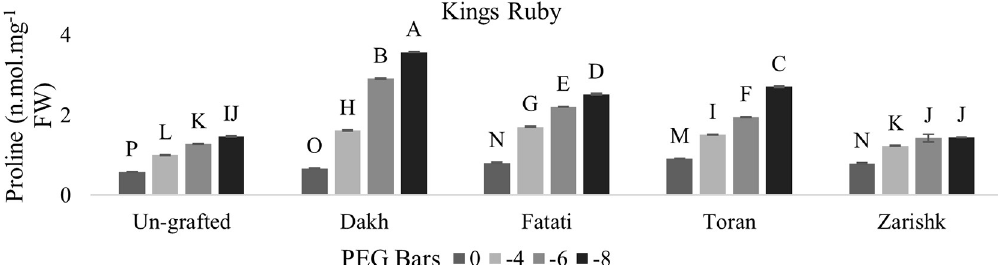
Fig 5. Proline content of un-grafted and grafted Kings Ruby scion variety on different wild grapevines under drought stress condition. Data is represented as mean SD and letters showed significant difference at p < 0.05.